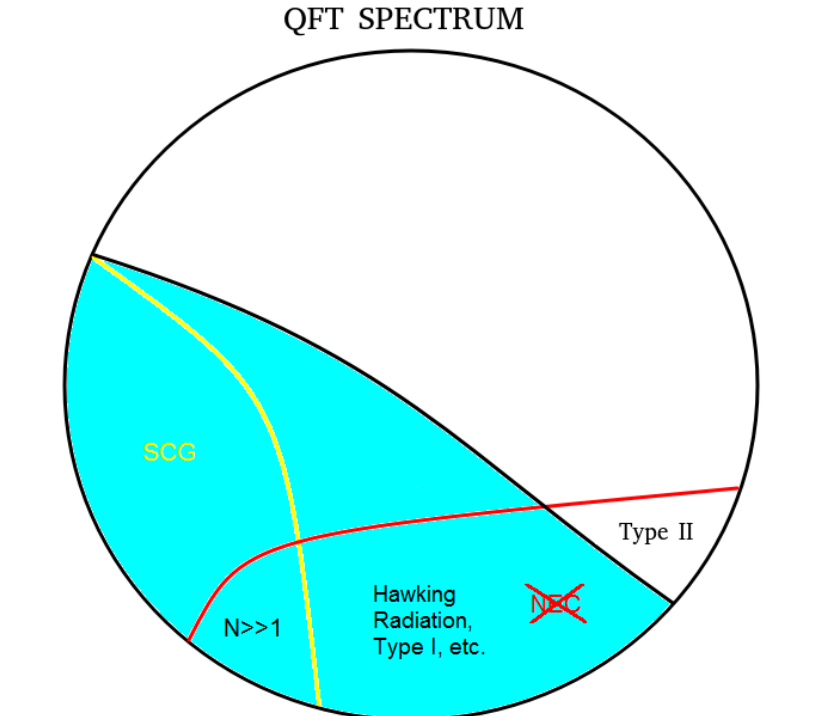
Figure 2 . The light blue represents all PQG states. Our statement, is that all states in this region satisfy (4.1). The region enclosed by the red line corresponds to the set of NEC violating states and the region enclosed by the yellow line to the set of SCG states. Notice that in this picture, there is an overlap between the SCG and NEC violating spectrum. The union of these regions represents NEC violating states in theories with a large number of species. The white part of the diagram represents states which cannot be treated within well-understood theories (for example states with large backreaction). ‘Type I’ refers to NEC violating states with small backreaction, while ‘Type II’ refers to NEC violating states with large